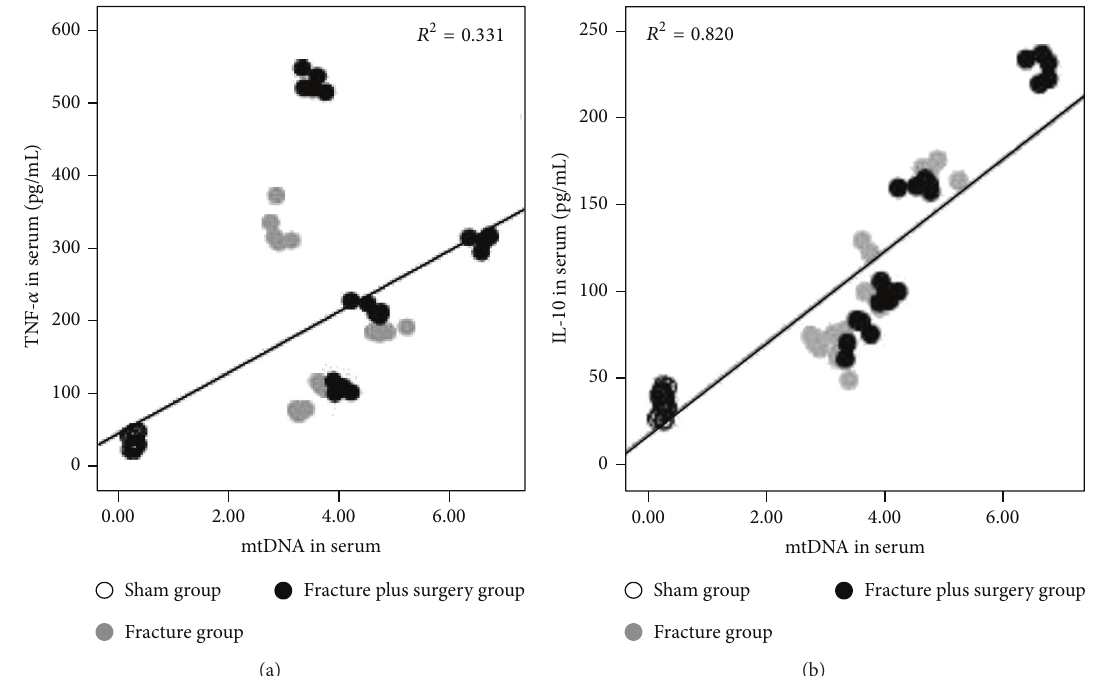
Figure 4: Scatter plots and regression lines showed that the serum TNF- 𝛼 (a) and IL-10 (b) concentrations exhibited a significant relationship with the serum mtDNA